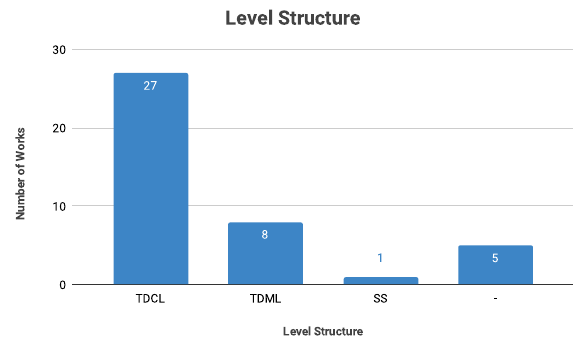
Figure 14. Number of works by level